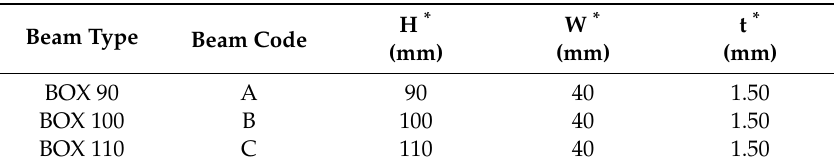
Figure 3. Shape and dimensions of the cross-sections of the beams (dimensions H, W, t are given in Table 2). Table 2. Dimensions of the beams’ cross sections involved.